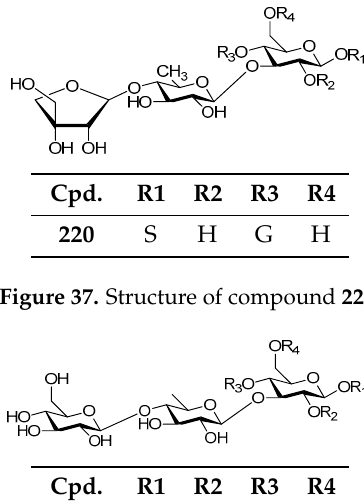
Figure 36. Structure of compound 219 .